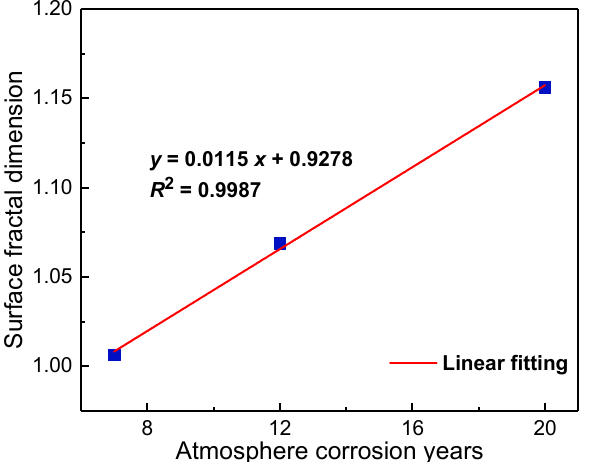
Figure 11. The surface fractal dimensions of the epoxy-coated specimens exposed for different numbers of years.